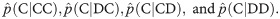
Distributions of each cooperation probability calculated separately for the combination of one’s own and the partner’s previous decisions.(A) Direct reciprocity game. (B) Generalized reciprocity game. Boxplots indicate the participant’s empirical cooperation probabilities: p(C|CC), p(C|DC), p(C|CD), and p(C|DD). The point on each boxplot, the box, the thick line in each box, and the whisker represent each participant, the IQR, the median, and the distances 1.5 × IQR, respectively. The open triangles represent the overall fraction of cooperation averaged over the participants (error bars represent 95% confidence intervals: ±1.96 × standard error). The filled circles and bars adjacent to the right-hand side of each boxplot indicate the predicted distributions of group-level cooperation probabilities inferred from the OPA model, p^(C|CC),p^(C|DC),p^(C|CD),andp^(C|DD). Each filled circles and bar represent the median and the 95% compatibility interval of the predicted distribution, respectively. Each label on the horizontal axis indicates the participant’s and his/her partner’s decision in the previous round: CC, both players had cooperated; DC, the participant defected while his/her partner cooperated; CD, the participant cooperated while his/her partner defected; and DD, both players defected.